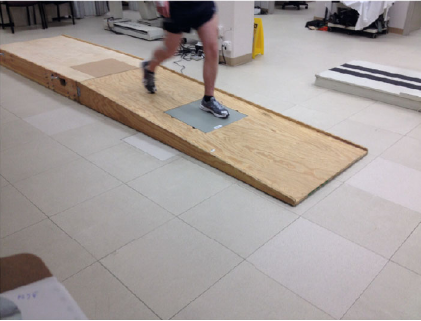
Figure 3: Data collection setup for the ramp walking trials.